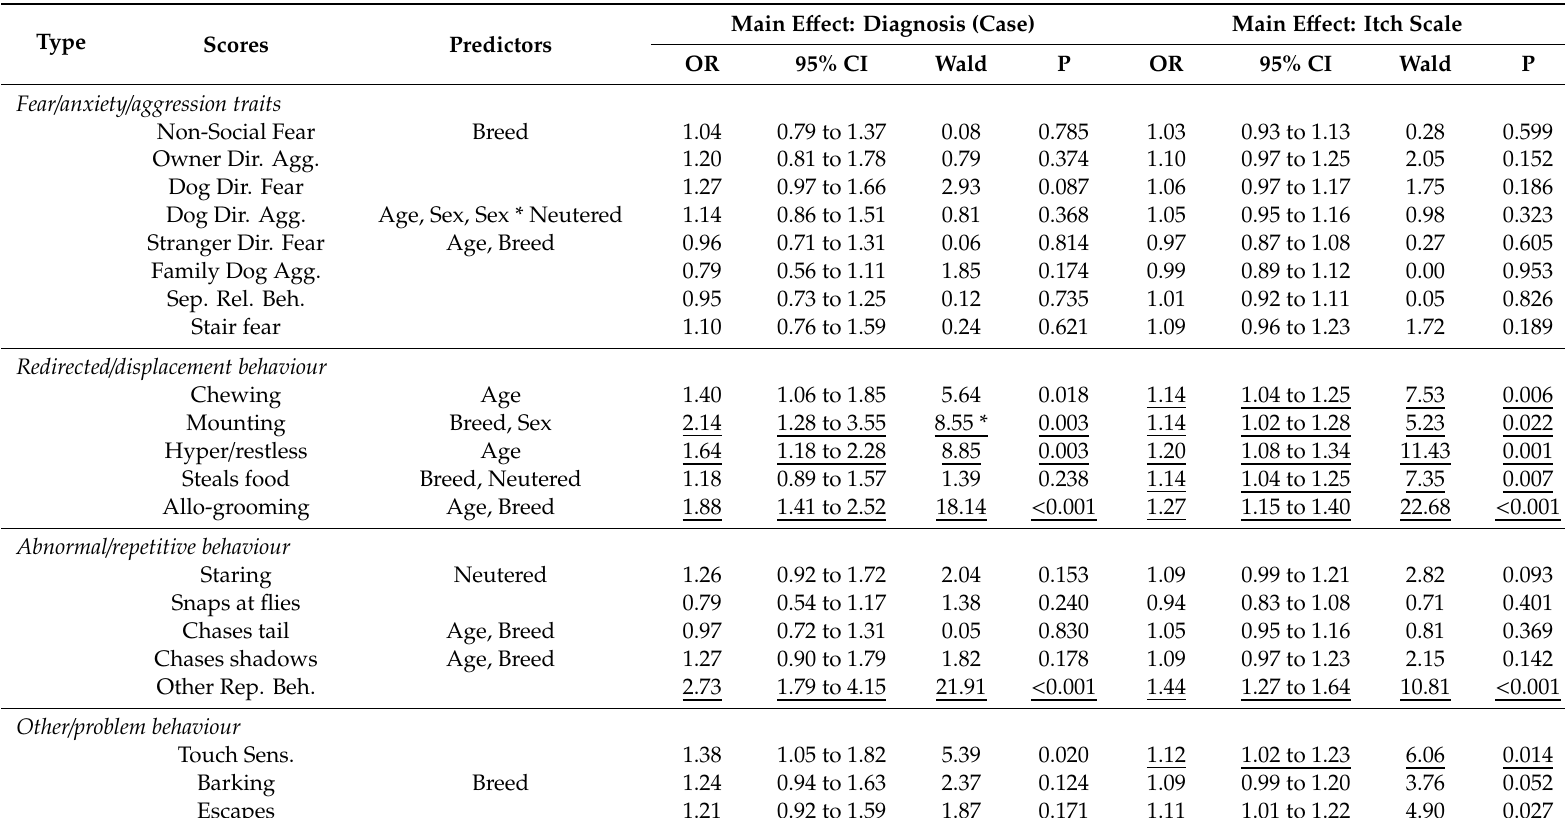
Table 4. Zero-inflated data, converted to binary (0, > 0) analysed via logistic regression. Statistics describe models with diagnosis (case) and scores on the Edinburgh Pruritus Scale (EPS) as the main e ff ect. Underlined items are considered statistically significant to a false discovery rate ( Q -value) of less than 5% ( < 0.05). Predictors remaining in the model were statistically significant to p < 0.05. B, the coe ffi cient for the main e ff ect; 95% CI, 95% confidence interval for B; Wald, chi-square value associated with B; P, p -value for B. Behaviour scores in this table have been grouped by type for ease of